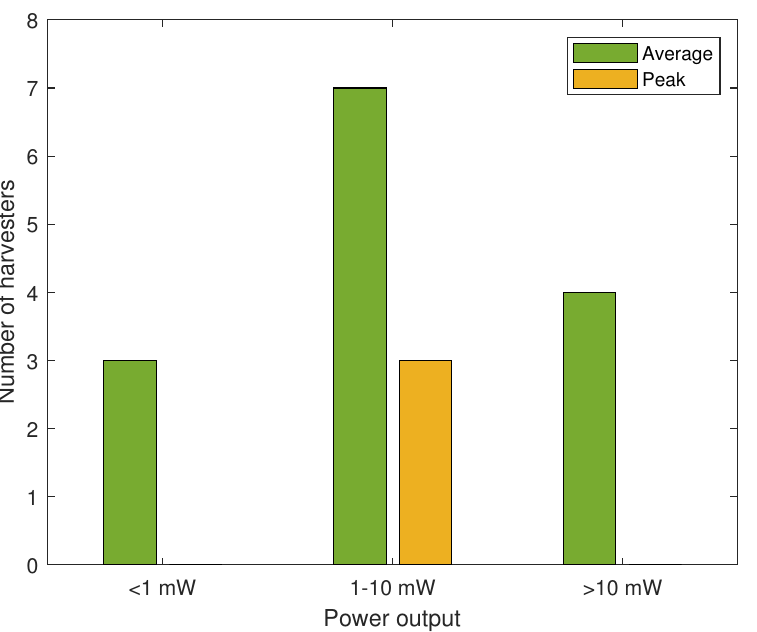
Figure 10. Bar graph with power outputs of 3D printed EM non-hybrid vibration harvesters grouped into three power